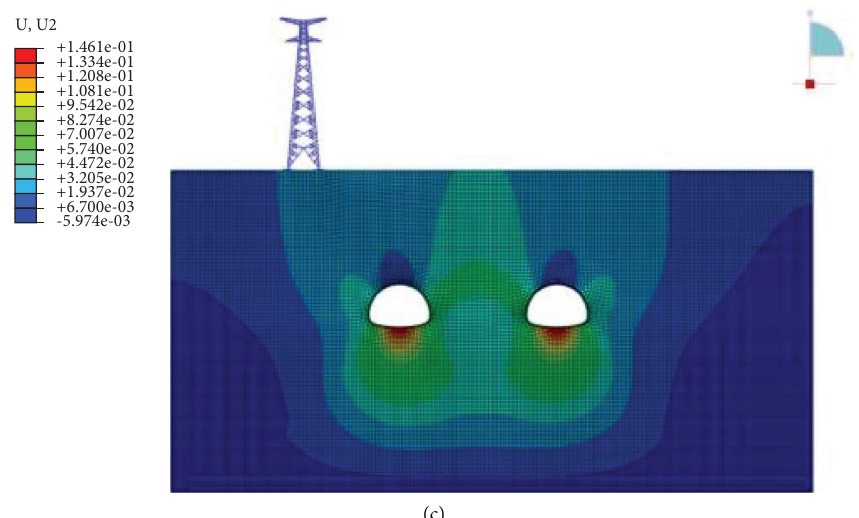
Figure 9: Vertical displacement cloud pictures under diferent construction sequence. (a) Scheme 1: excavation of the left tunnel followed by the right tunnel. (b) Scheme 2: excavation of the right tunnel followed by the left tunnel. (c) Scheme 3: excavation of the two tunnels at the same